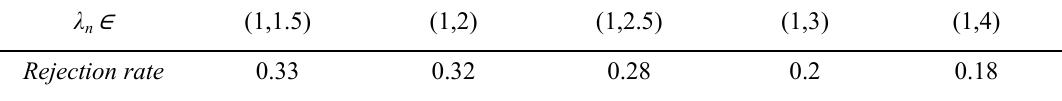
Table 8. Rejection rates for alternative agent-specific cost factors